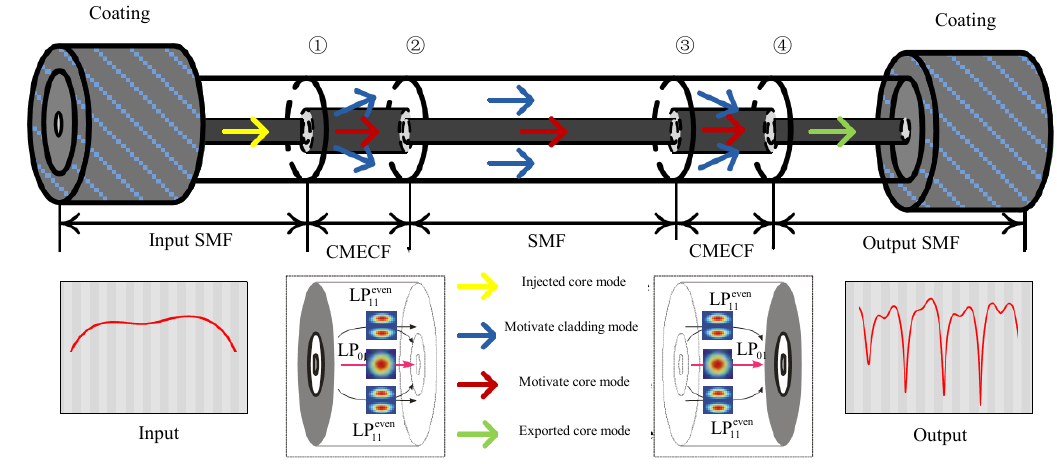
Fig. 2 Structures of MZI (the inset is excited and coupled modes in the